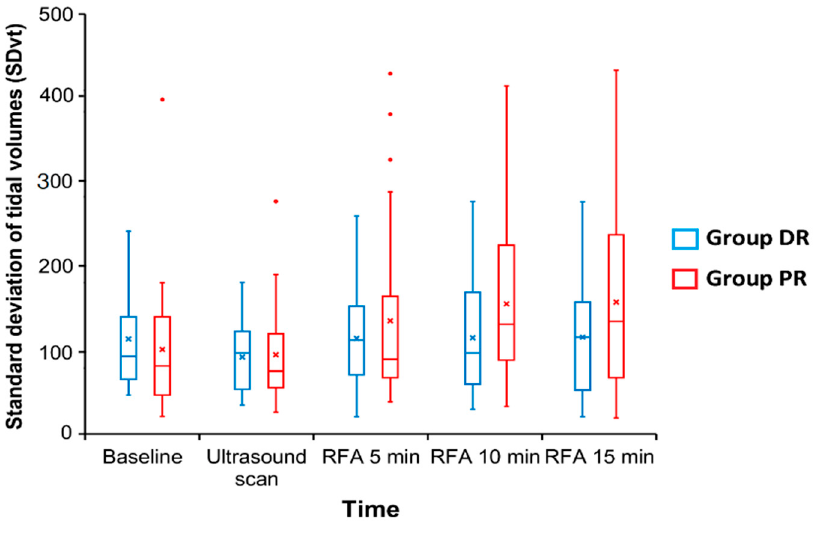
Figure 2. Standard deviation of the tidal volume during sedation between the DR and PR groups. DR, dexmedetomidine-remifentanil; PR, propofol-remifentanil; RFA, radiofrequency ablation.